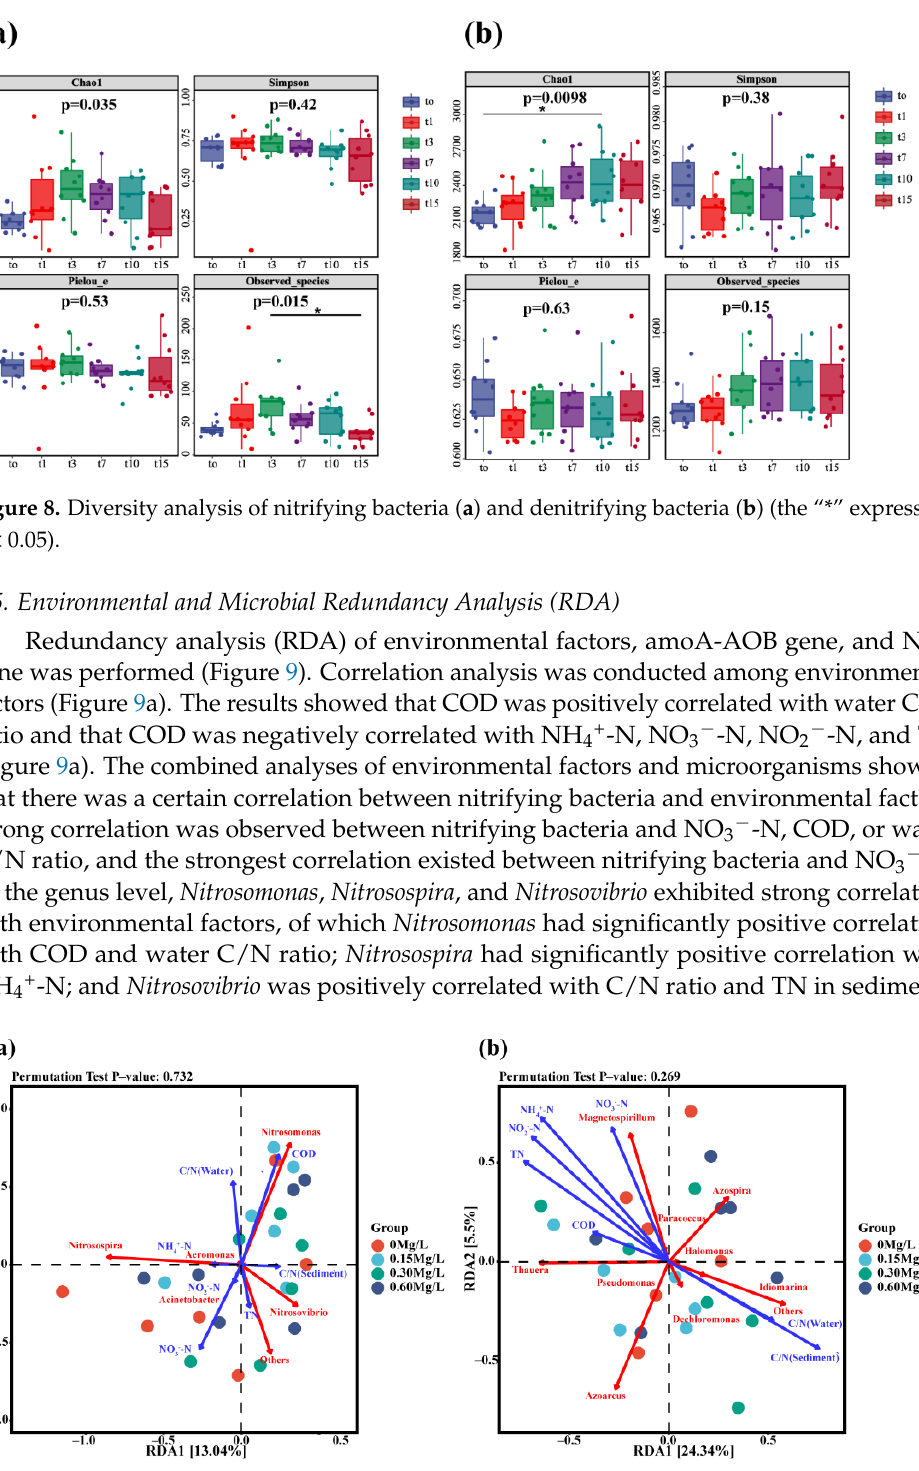
( b ) Figure 7. Heat maps of nitrifying ( a ) and denitrifying ( b ) bacterial species composition (at species level). 3.4. Diversity Analysis of Nitrifying and Denitrifying Bacteria In this study, the observed species index and Chao1 index were used to analyze the diversity of nitrifying and denitrifying bacteria. The results showed that the diversity of nitrifying and denitrifying bacteria showed an obvious initial upward and then down- ward trend over the 15-day treatment ( p < 0.05). The species diversity of nitrifying bacteria was increased (days 0 – 3), remained stable (days 7 – 10), and decreased (days 10 – 15) (Figure 8a). The species diversity of nitrifying bacteria on day 15 was similar to that on day 0.